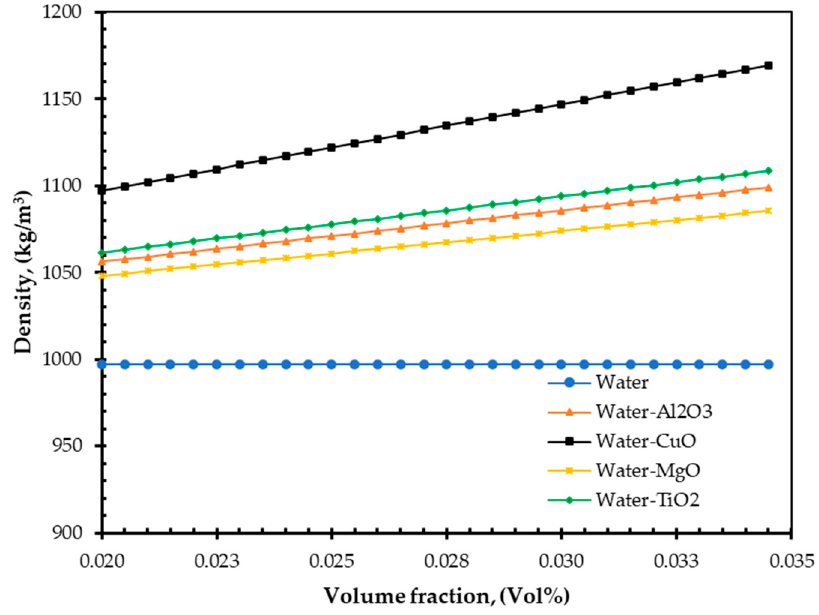
Figure 8. Effect of volume fraction on density.